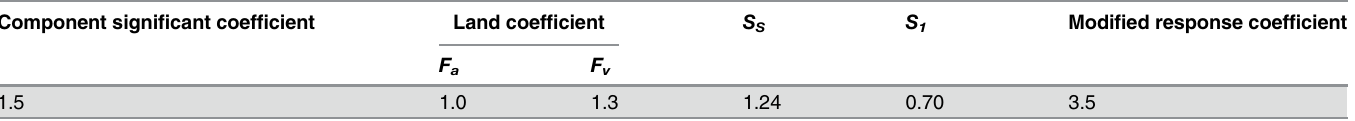
Table 6. Spectrum Parameters.